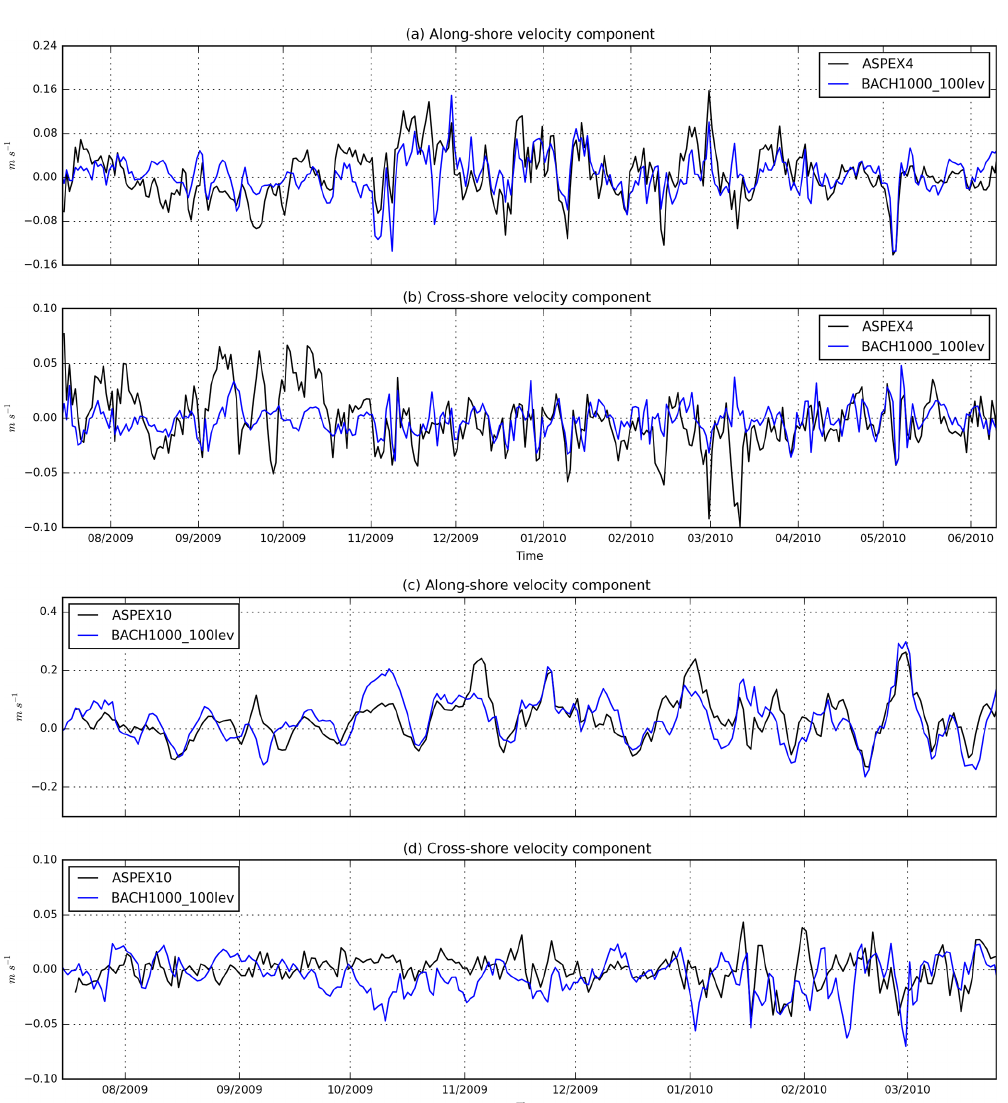
Figure 7. Comparison of the 1-day mean and depth averaged along-shore and cross-shore velocity components between ADCP measurements (black) and BACH1000_100lev currents (blue) at the location of ASPEX4 (Fig. 7a and b) above the continental shelf and ASPEX10 (Fig. 7c and d) above the continental slope. The orientation of the along-shore and cross-shore components is relative to the